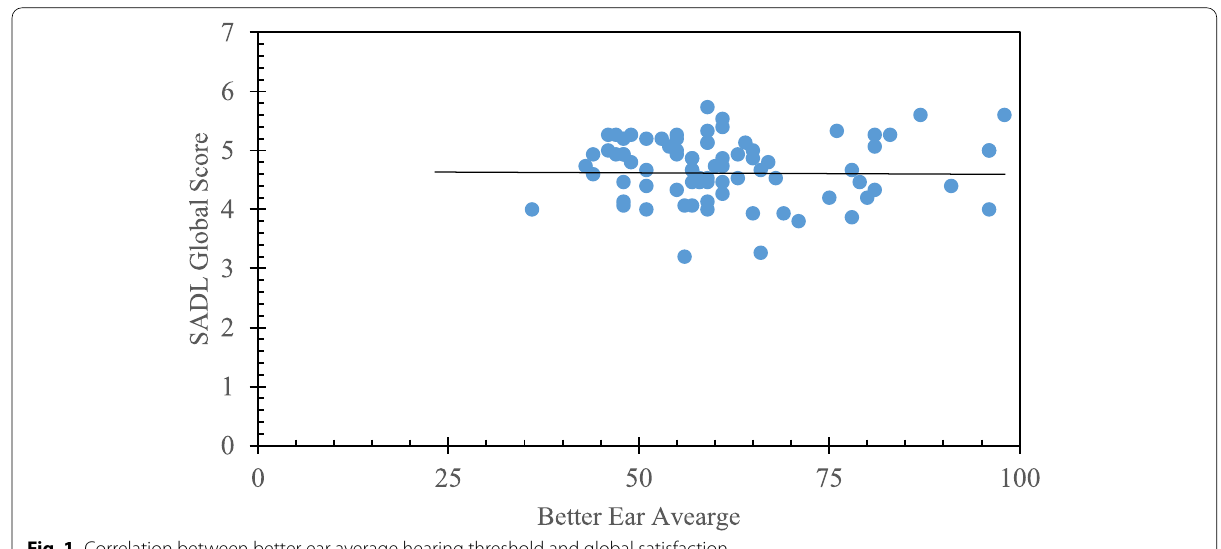
Fig. 1 Correlation between better ear average hearing threshold and global